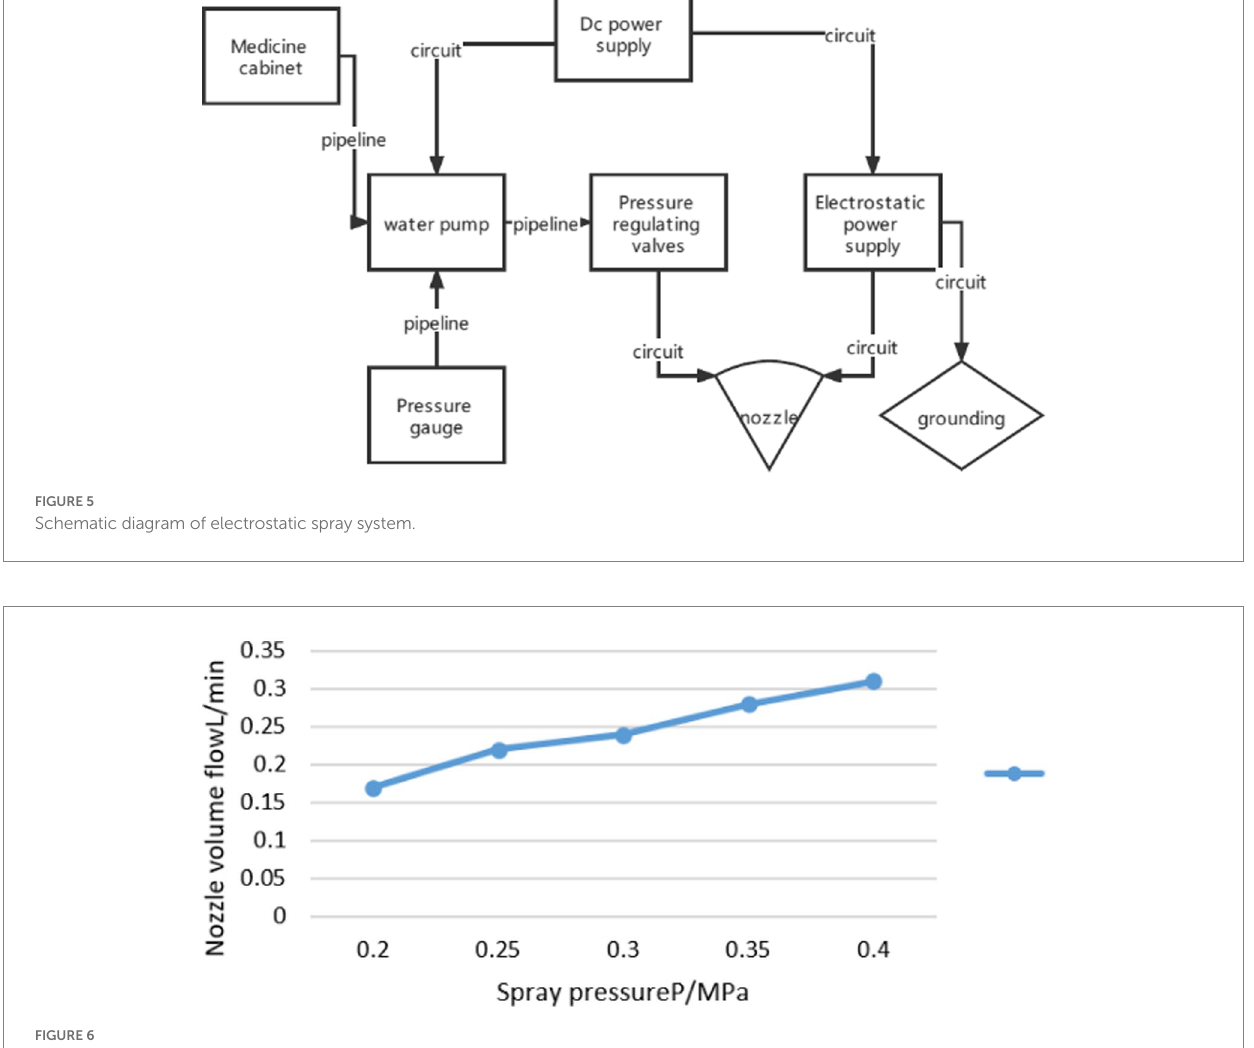
FIGURE 6 Relationship between spray pressure and volume of